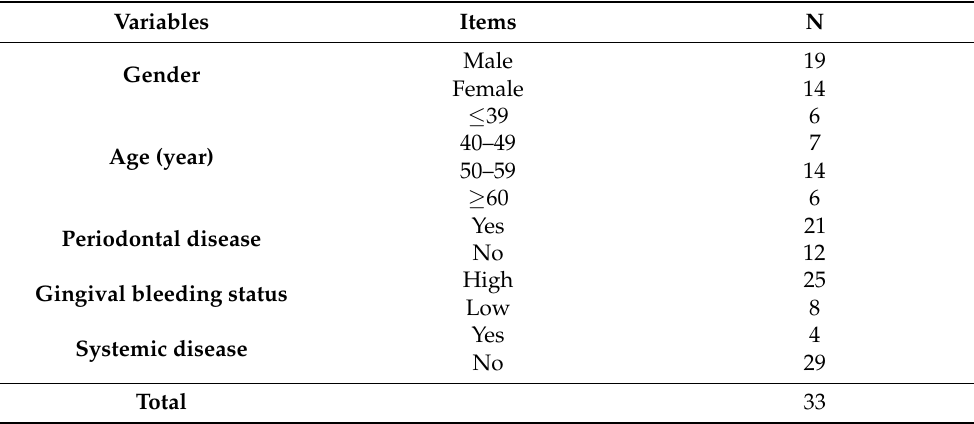
Table 1. Characteristics of the